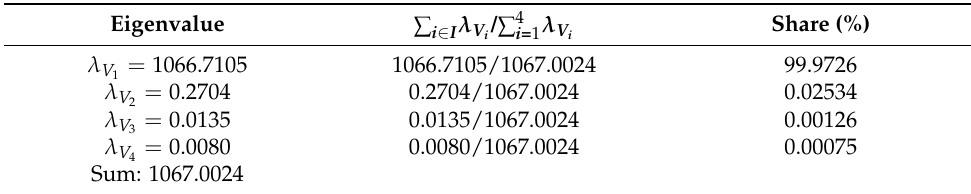
Table 4. Share of the eigenvalues.